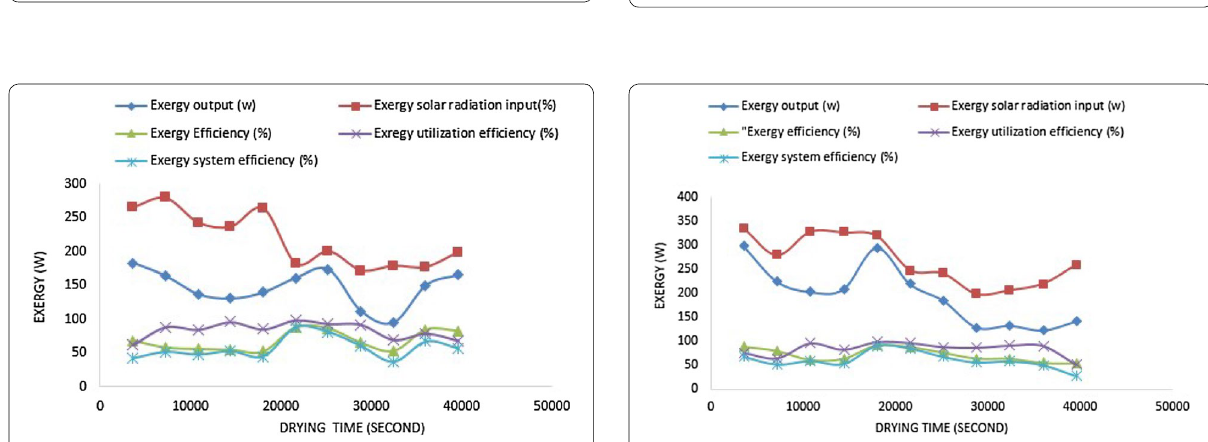
Fig. 17 Variation of efficiency as a function of drying time and exergy in the drying chamber (1st day) potato